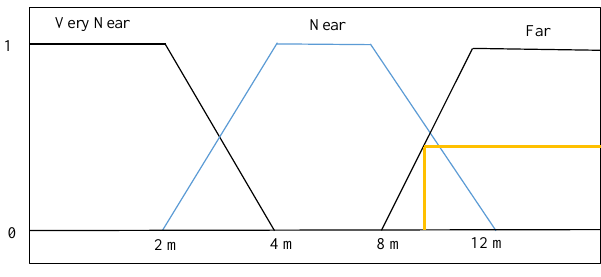
Figure 2. Fuzzification of the input